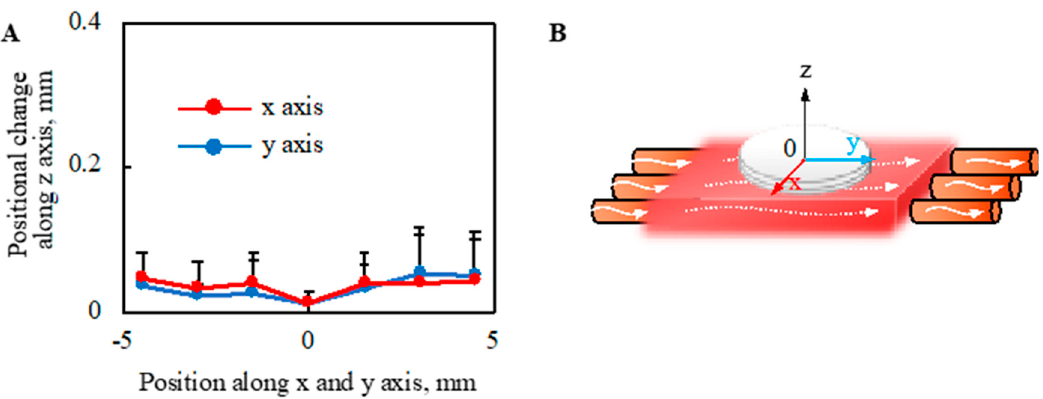
Figure 8. Evaluation of morphological change in the direction of the z axis owing to the perfusion. The positional change of the cell tissue surface owing to perfusion ( A ) is shown ( n = 3) (details are shown in Figure A3). Note that the schematic image to show each axis is shown ( B ). Note that the perfusion speed was 5 mL/min in this figure.